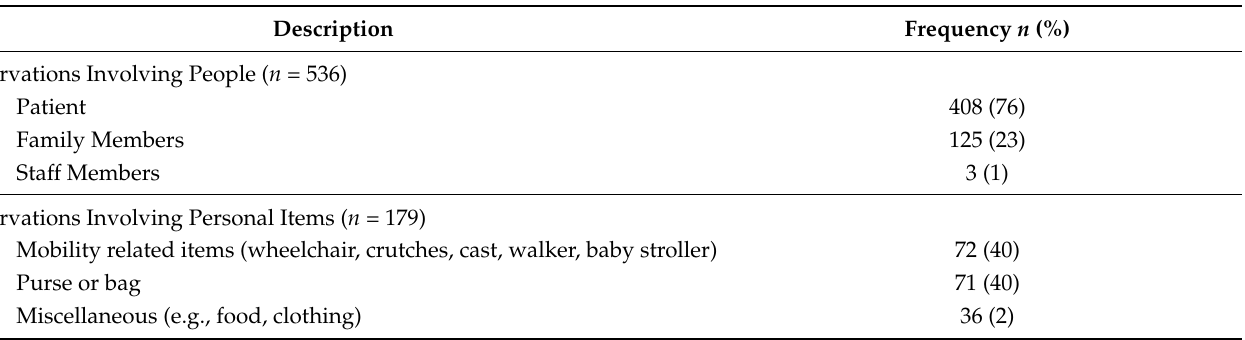
Table 2. Overview of DOTT